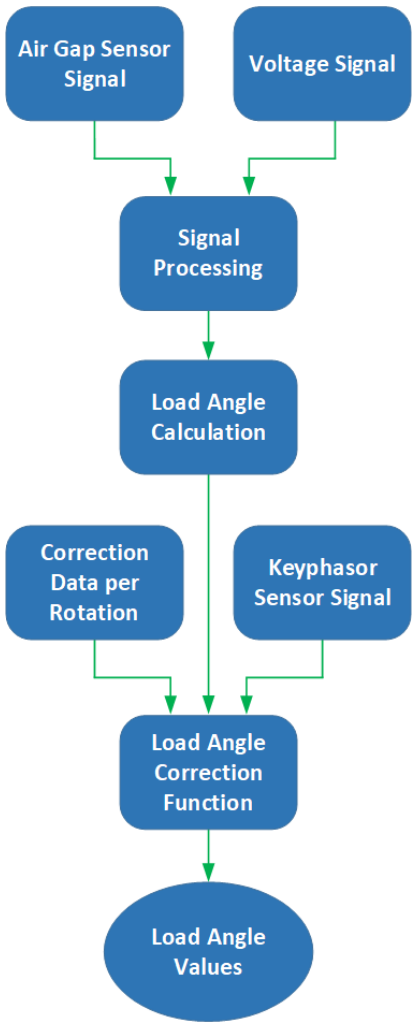
Figure 10. Flowchart of the developed real time load angle measurement algorithm.